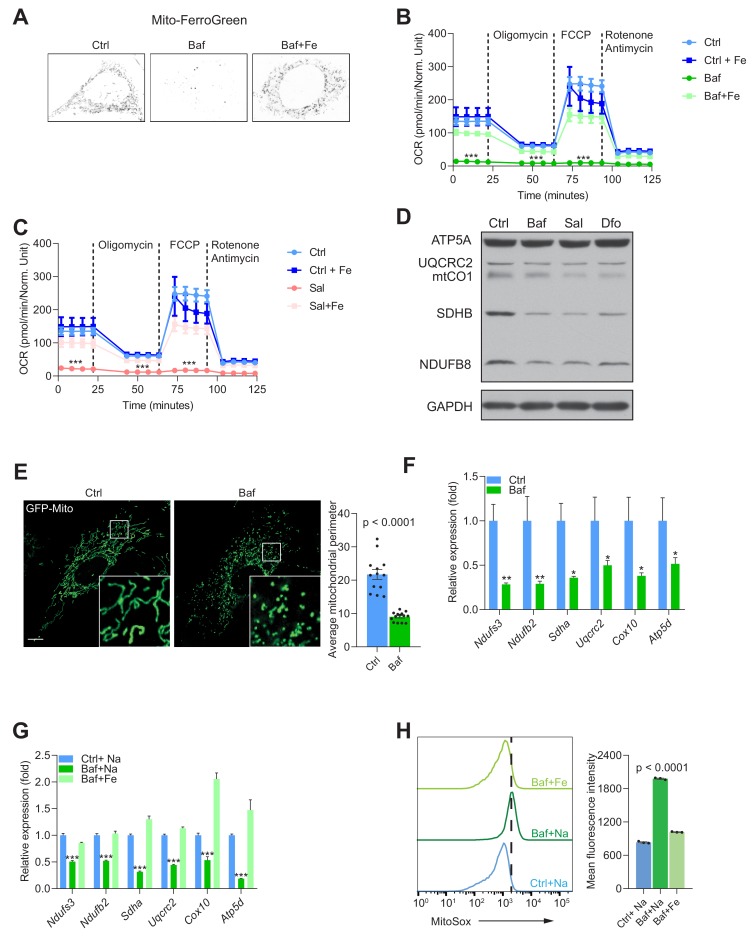
Mitochondrial biogenesis and function are dependent on endolysosomal iron supply.(A) Representative image Mito-FerroGreen staining of mitochondrial labile iron pools in control, 500 nM Baf- and 500 nM Baf + 150 µM Fe-citrate treated fibroblasts. Note the barely detectable labile iron levels in mitochondria of Baf-treated fibroblasts. (B–C) Mitochondrial oxygen consumption rates (OCR) in 500 nM Baf- and 500 nM Baf-treated fibroblasts with 150 µM iron citrate supplementation (B) or in 500 nM Sal- and 500 nM Sal-treated fibroblasts with 150 µM iron citrate supplementation (C). Results represent mean ± SEM, three independent experimental replicates. Each experimental replicate is calculated from the average of 8 technical replicates. ***p<0.001, Welch’s one-way ANOVA with Dunnett’s correction for multiple comparison (all experimental groups compared to Baf- or Sal-treated cells). (D) Western blot of whole cell extracts showing ATP5A, UQCRC2, mtCO1, SDHB and NDUFSB in control, 500 nM Baf- and 500 nM Sal-treated fibroblasts (n = 6). 300 µM Dfo is used as positive control for iron deficiency. Note the reduction of mitochondrial proteins in treated cells relative to controls. GAPDH is used as loading control. (E) Representative images of fibroblasts transfected with GFP-Mito and treated with 500 nM Baf for 24 hr to show the mitochondrial network. Note the prevalent mitochondrial fragmentation in Baf-treated fibroblasts. Number of cells is shown as black dots per condition in bars representing mean ± SEM of mitochondrial perimeter from three independent experiments. p value is estimated by the Mann-Whitney U-test. Scale bar, 10 µm. (F) Transcript levels of nuclear-encoded mitochondrial genes in 500 nM Baf-treated fibroblasts. Bars depict mean ± SEM of six independent experimental measures. *p<0.05; **p<0.01; ***p<0.001, unpaired two-tailed t-test with Welch’s correction. (G) Transcript levels of nuclear-encoded mitochondrial genes in 500 nM Baf-treated fibroblasts and 500 nM Baf-treated fibroblasts with150µM iron citrate supplementation. Results are shown as mean ± SEM, n = 8. *p<0.05; **p<0.01; ***p<0.001, Welch’s one-way ANOVA with multiple test corrections made by the Dunnett’s method. All comparisons were made between Baf-treated cells and other experimental conditions. (H) Mitochondrial superoxide levels in 500 nM Baf- and 500 nM Baf-treated fibroblasts with 150 µM iron citrate supplementation. Differences are depicted as mean fluorescent intensities of the superoxide-sensitive and mitochondrial-targeted dye, Mitosox. Error bars represent SEM of three independent experimental measures (black dots). p value is Welch’s one-way ANOVA with Dunnett’s correction for multiple corrections (all conditions compared to Baf-treated cells).